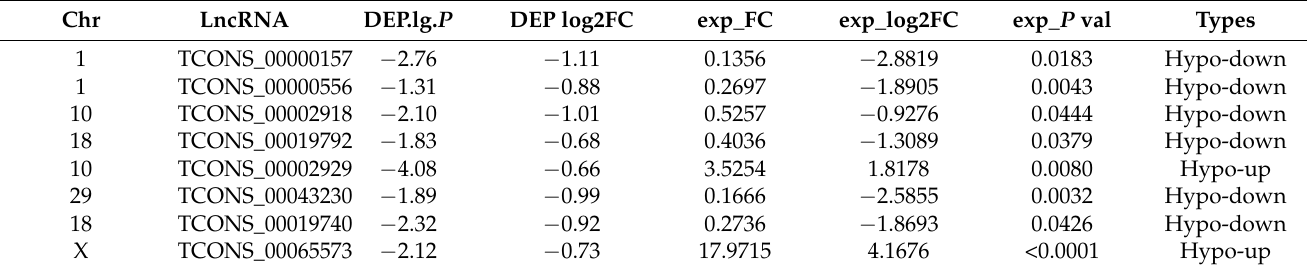
Table 1. Distribution of lncRNAs with a marked change in both RNA expressions and m 6 A methyla- tion levels between group CY6 and